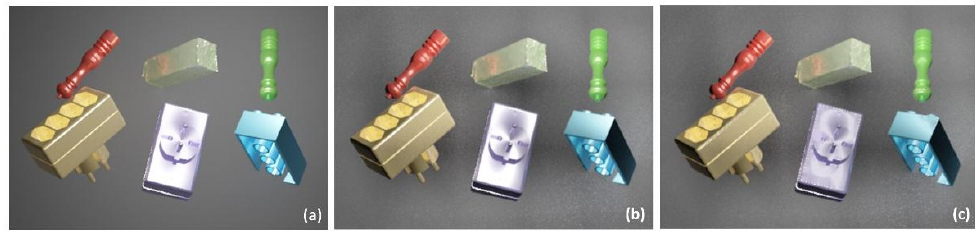
Figure 9. Preprocessing steps of the input data. ( a ) Input image; ( b ) After applying CLAHE to image ( a ); ( c ) After applying inpainting to image ( b ). ( a ); ( c ) After applying inpainting to image ( b